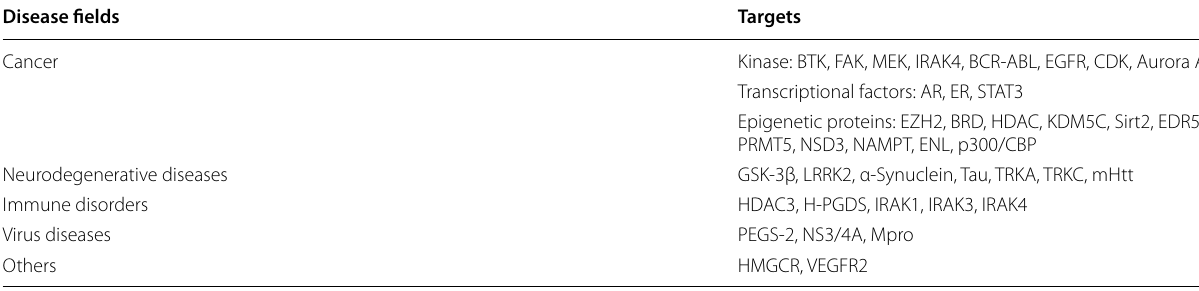
Table 6 Diverse PROTACs targets on different diseases Disease